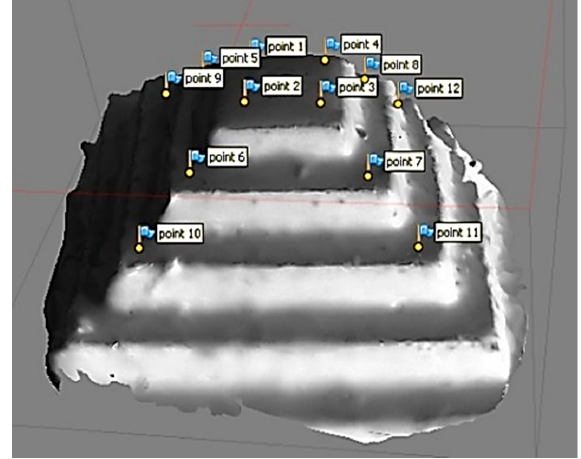
Figure 18. 3D model of a micro-pyramid.